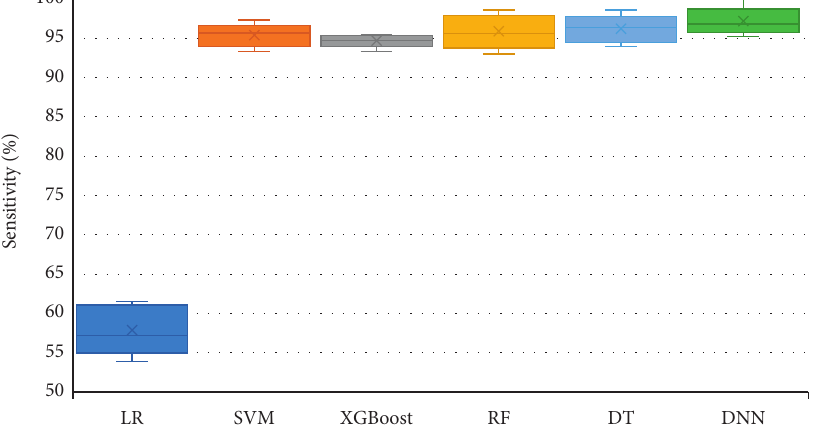
Figure 11: Performance comparison of classifiers based on sensitivity.